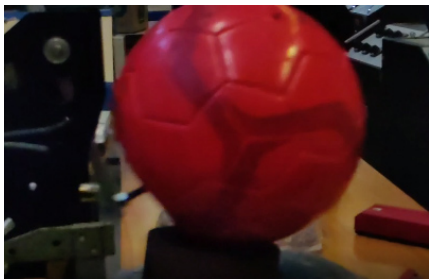
Figure 12. Ball deformation after phase